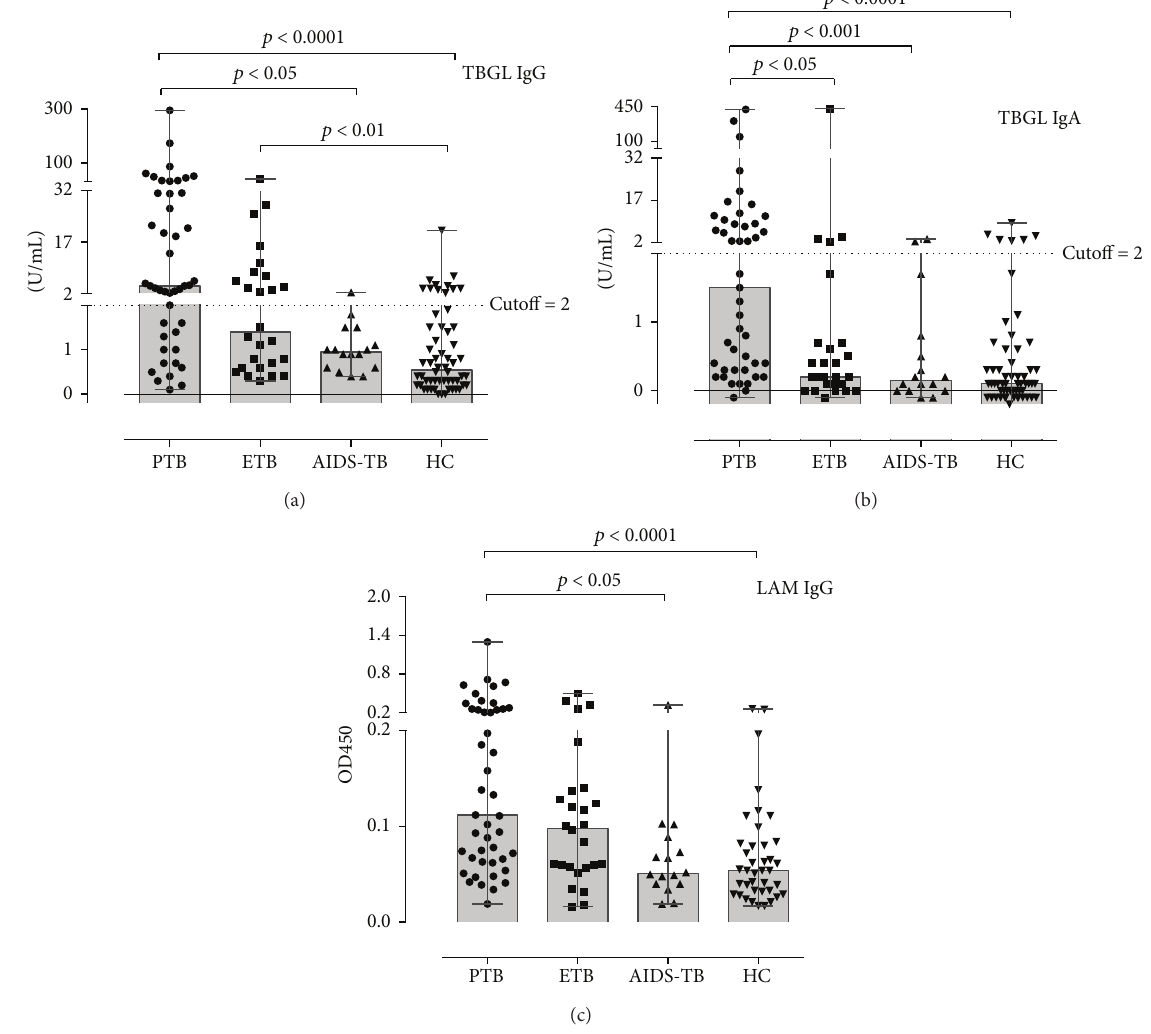
Figure 1: Detection of anti-TBGL IgG, anti-TBGL IgA, and anti-LAM IgG in TB patients and HC. PTB = pulmonary TB; ETB = extrapulmonary TB; HC = healthy control. Anti-TBGL antibody titers were evaluated in U/mL, and the anti-LAM IgG reactivity was assessed as OD